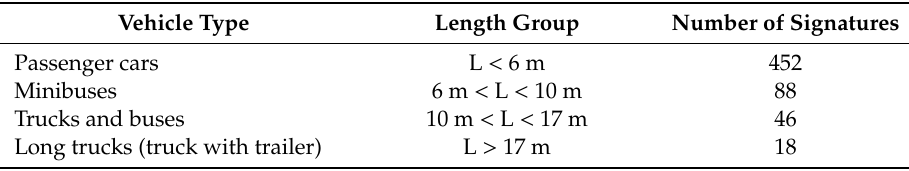
Table 2. Number of signatures by groups in the